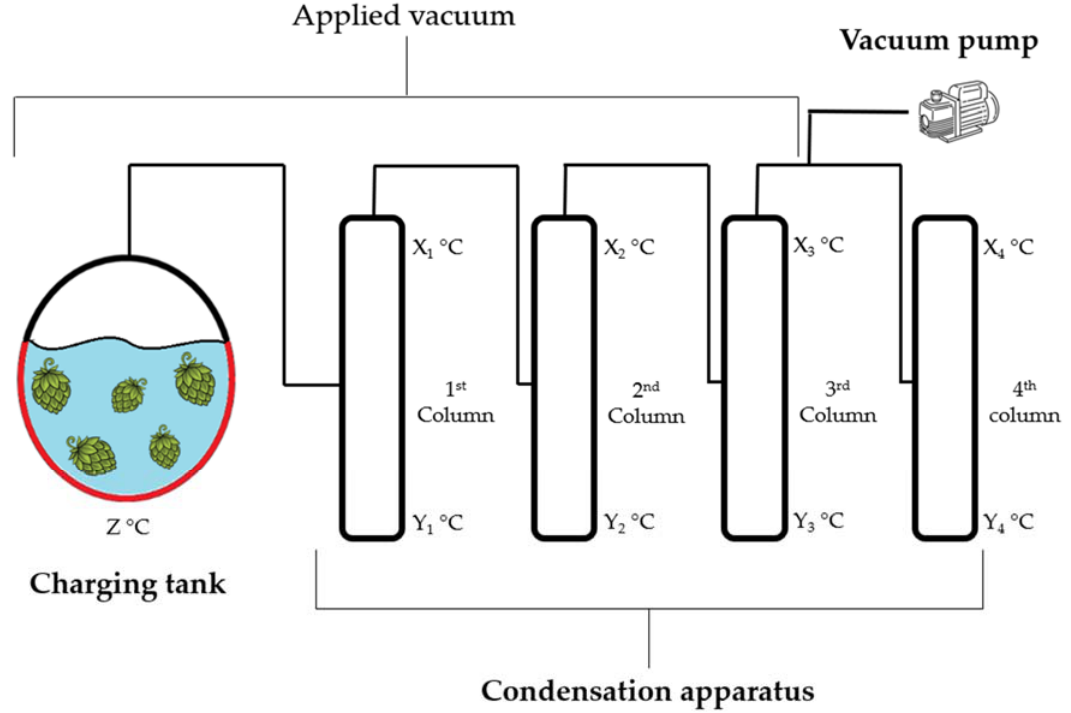
Figure 2. Scheme of the MEFCUV system. Starting from the left: charging tank; condensation apparatus; vacuum pump. Temperature in each part of the system can be regulated independently.